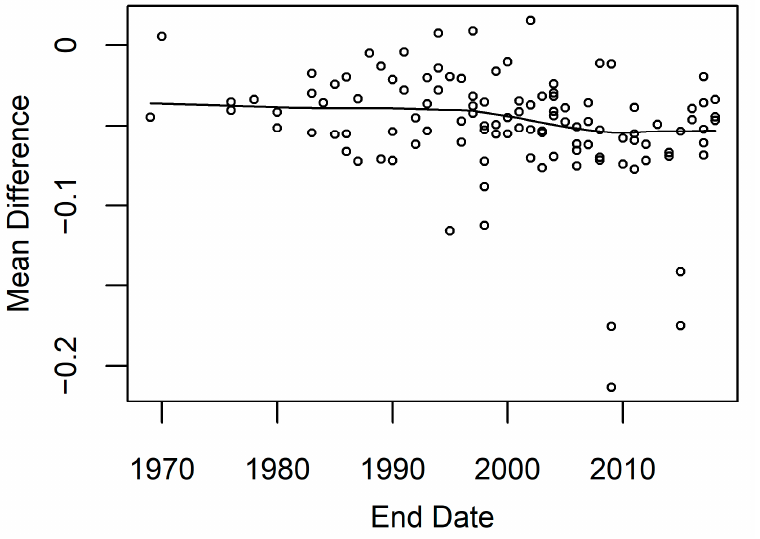
Figure 9. Restoration project end date versus mean difference. Mean difference is the model error calculated for Landsat observed minus predicted EVI. The project end dates for 128 restoration projects were obtained from EcoAtlas from their Habitat Projects dataset. A smoothing curve was fitted to the data using loess to estimate the trend within the data.